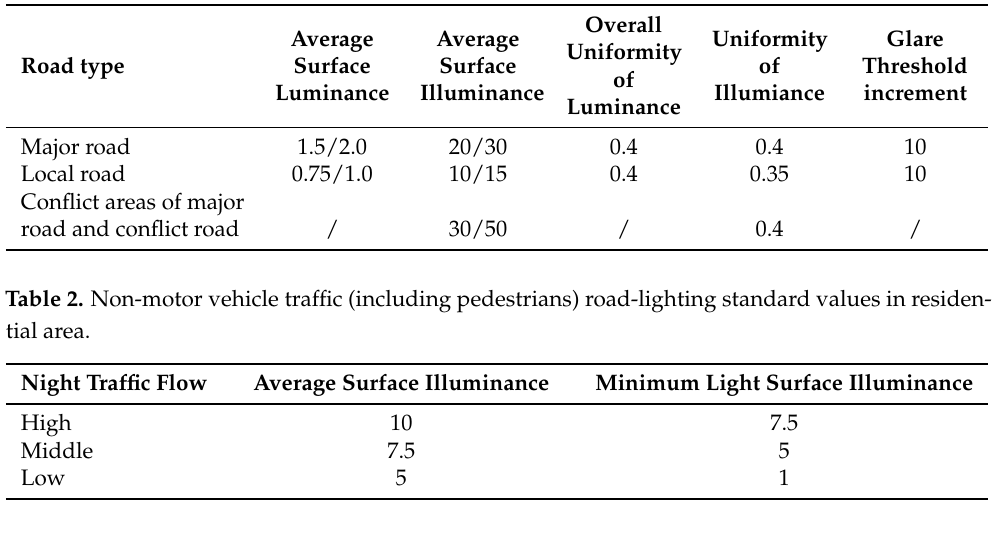
Table 1. Motor vehicle traffic road-lighting standard values.